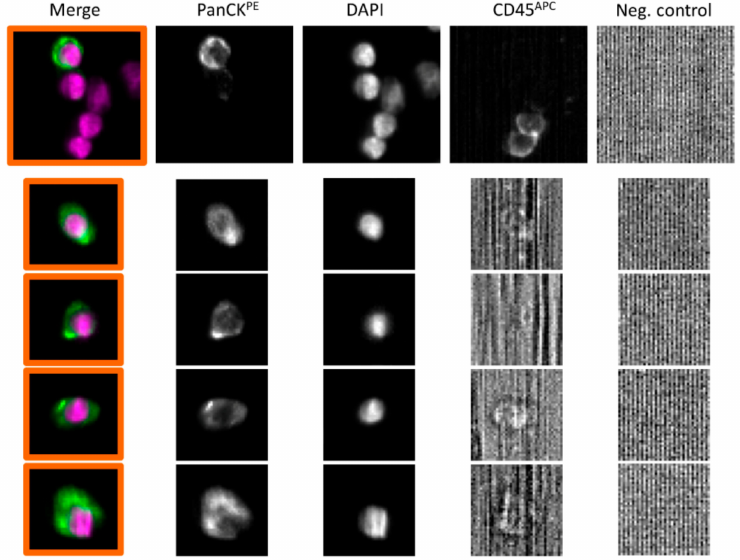
Figure 2. Representative images of CTCs from patients with high-risk PCa, that was detected using the CellSearch ® system. Cells were identified as tumor cells according to the following criteria: EpCAM-positive, panCK-positive, DAPI-positive, CD45-negative and negative for the last channel. CK: Cytokeratin; PanCK: anti-CK8, -18, -19 antibodies; PE: Phycoerythrin; APC: